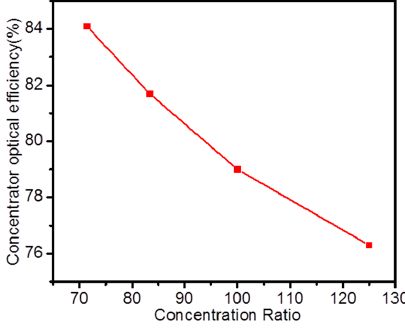
Figure 9. The dependence of concentrator optical efficiency and concentration ratio.